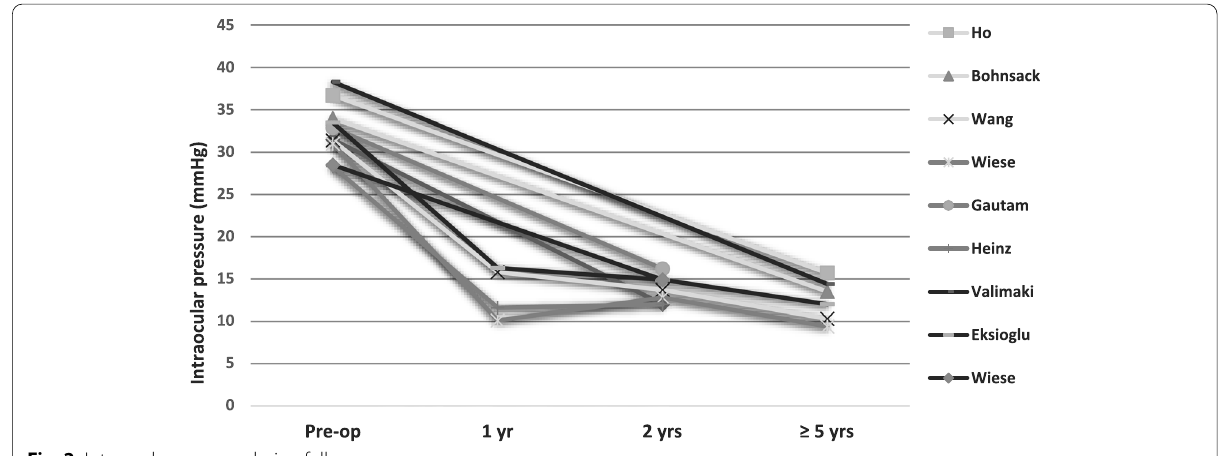
Fig. 2 Intraocular pressure during